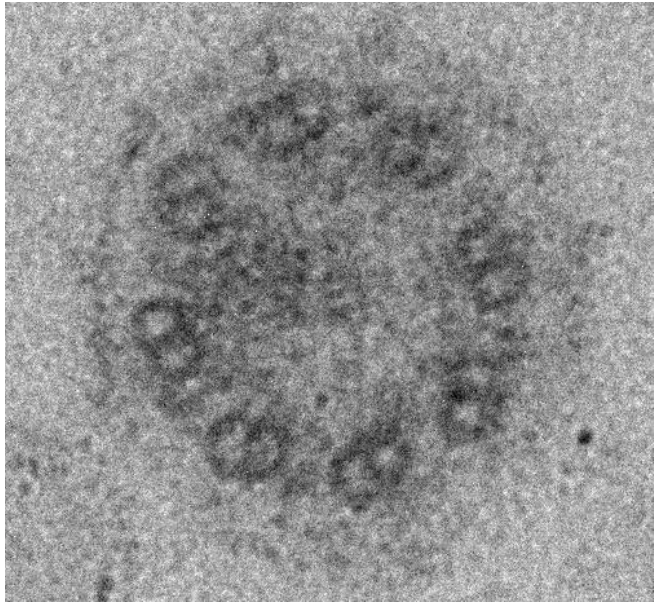
Figure 1. Electron microscopy analysis of the nasal mucosa of the patient and a normal control. In a normal subject ( A ), the outer arms of dynein (white arrows) can be observed, whereas these outer arms are lacking in the present patient ( B ). The photograph in ( A ) has been reprinted with permission from reference No. 3.